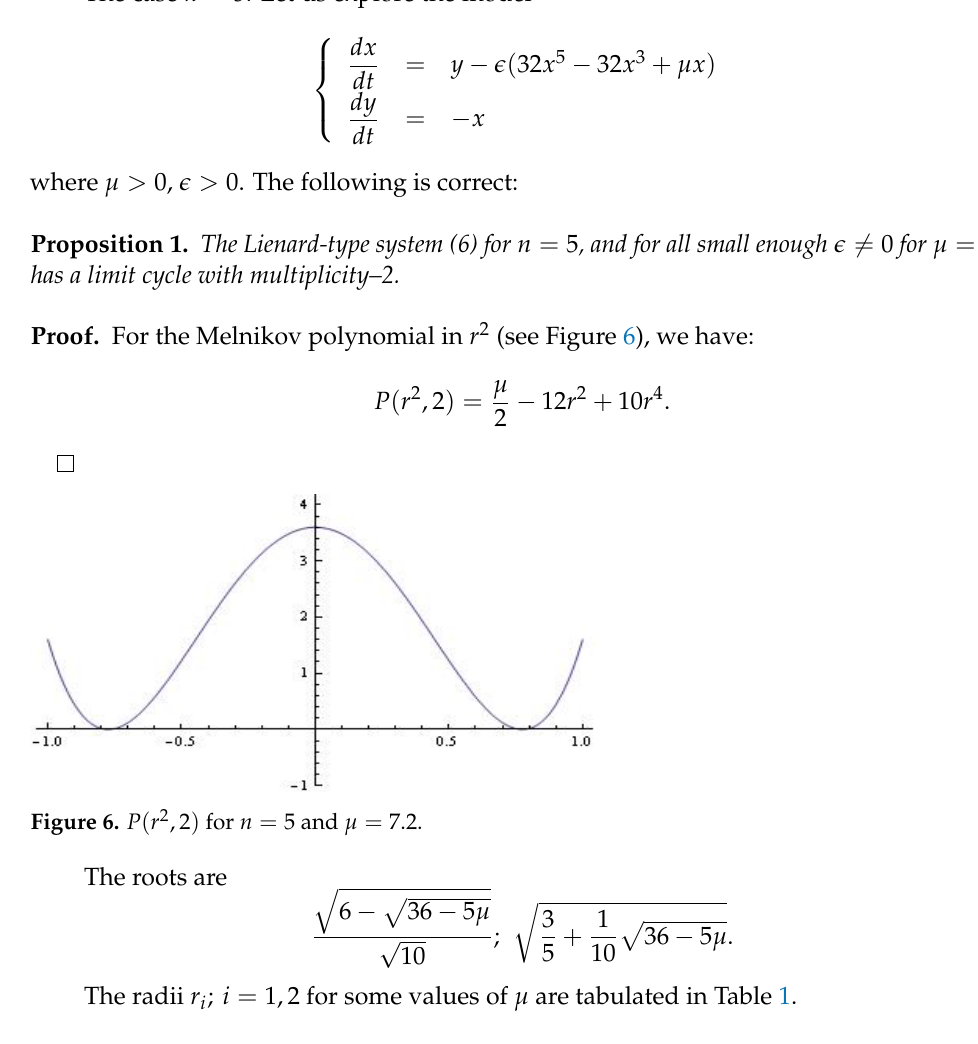
Table 1. The radii r i ; i = 1,2 for some values of µ